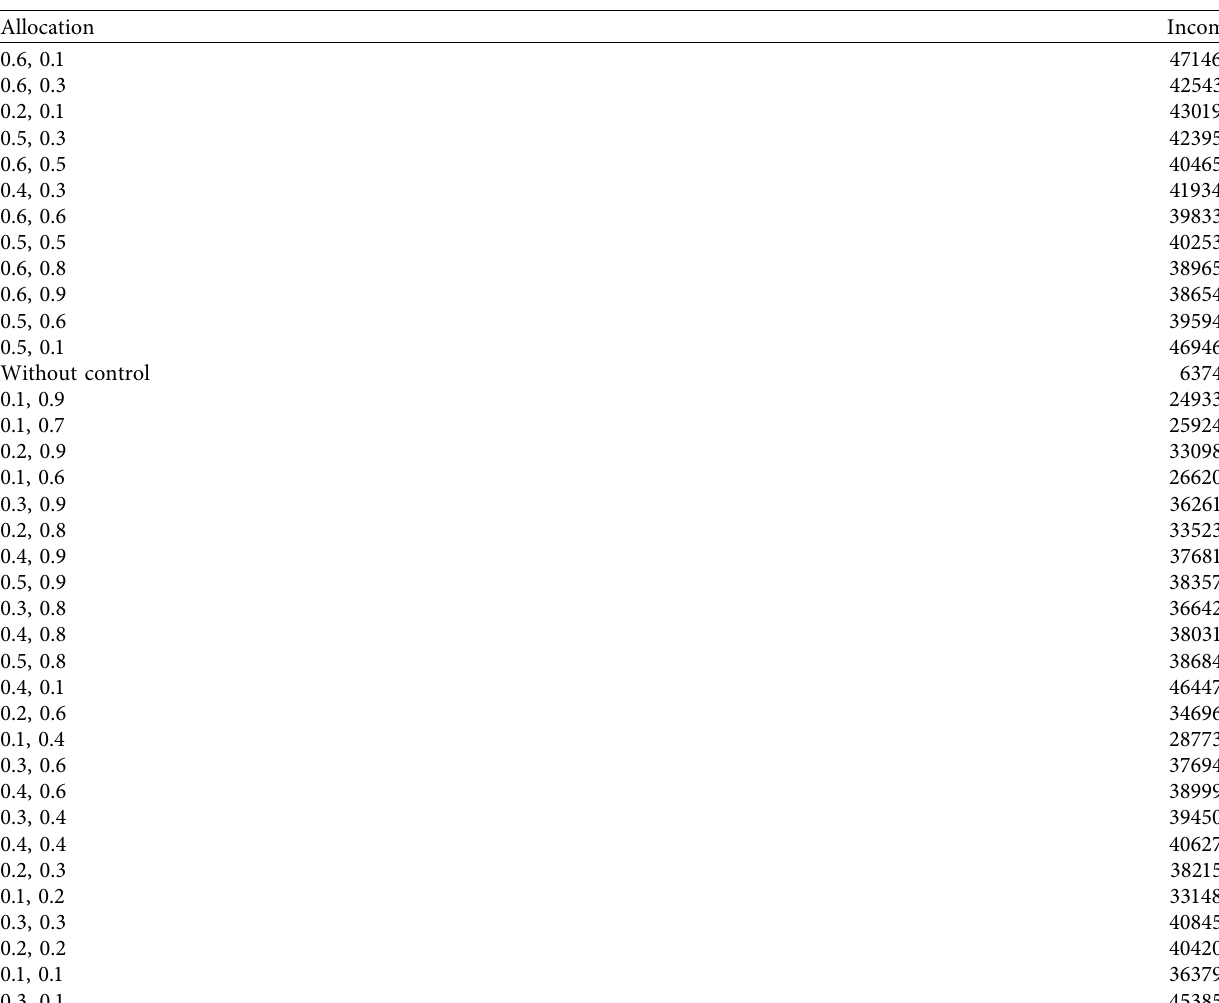
Table 1: Scheme distribution and economic benefits under control.